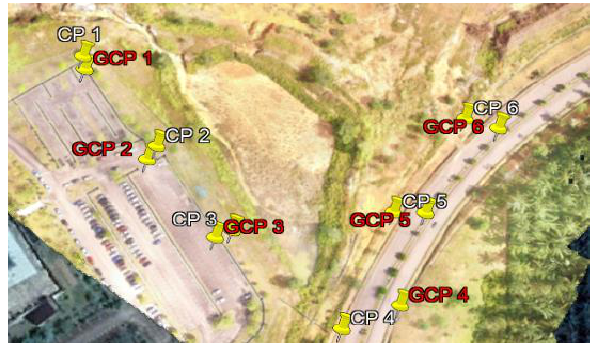
Figure 3. GCPs and CPs Distribution at study area